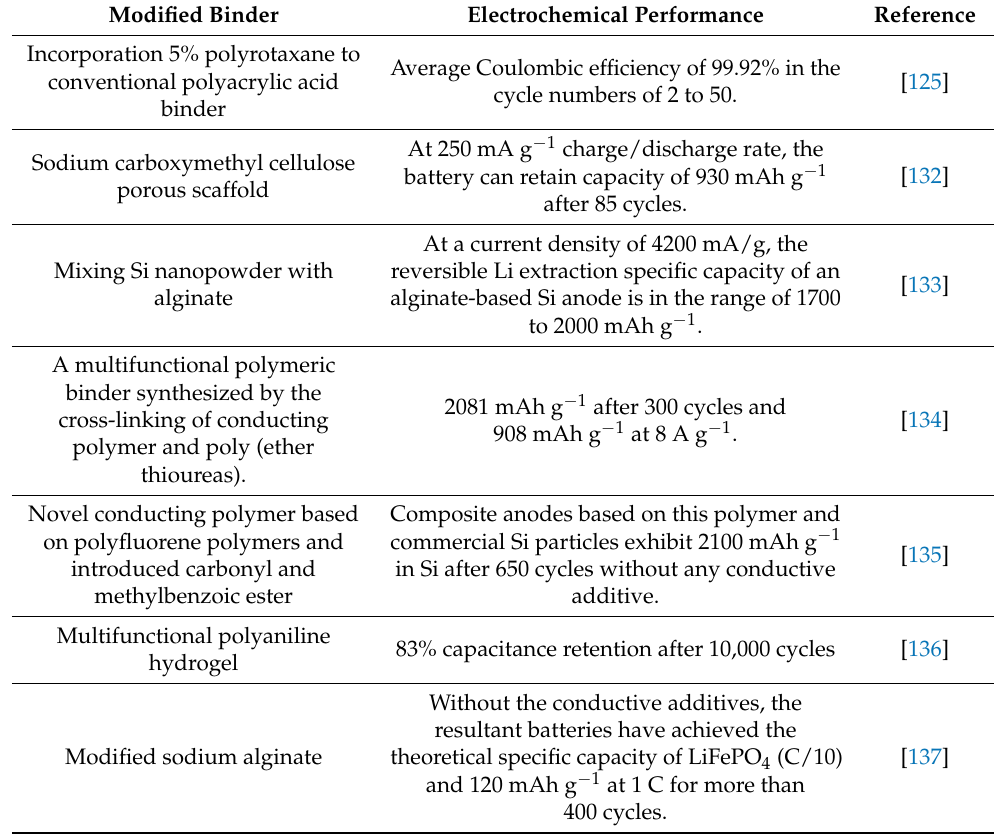
Table 4. Binder to improve battery